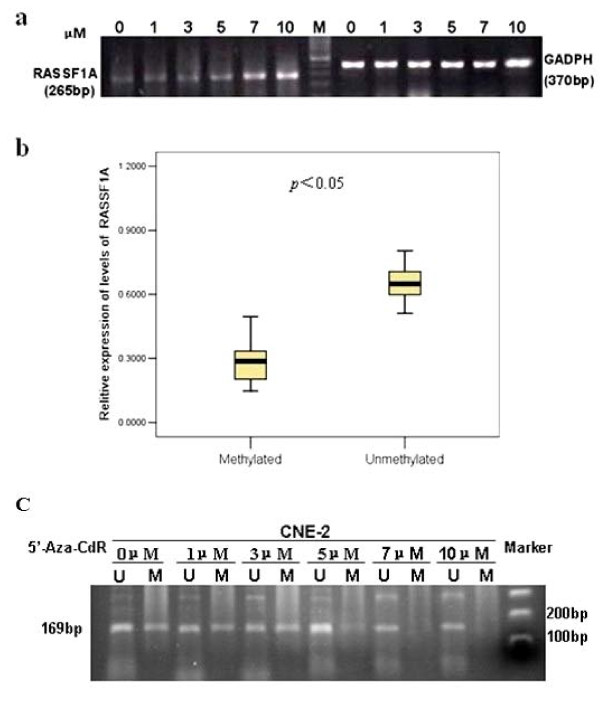
(a) Re-expression of RASSF1A by treatment with 5-aza-2'-deoxycytidine in CNE-2 cell lines at different concentration (0, 1, 3, 5, 7, 10 μmol/L), and GAPDH was amplified as an internal control. (b) Summary of RASSF1A expression in RASSF1A-methylated and--unmethylated NPC primary tumors. Inactivation of RASSF1A expression was significantly correlated with promoter hypermethylation of RASSF1A (p < 0.05, Mann-Whitney's U test). (c) The methylation status of RASSF1A after the treatment of 0, 1, 3, 5, 7, 10 μmol/L of 5-aza-2'-deoxycytidine in CNE-2 cells.